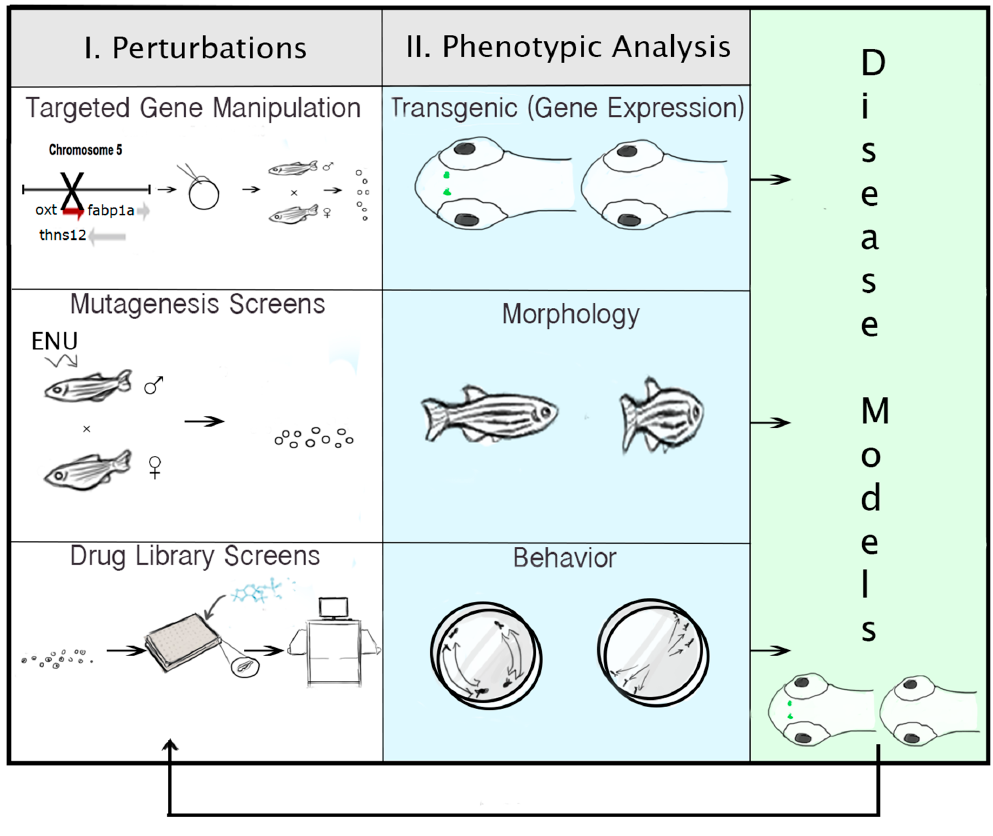
Figure 1. Overview of approaches for investigating PWS using zebrafish. ( I ) Genes and molecular pathways can be genetically or pharmacologically perturbed. ( II ) The effect of perturbations can be evaluated using a variety of phenotypic analyses. PWS endophenotypes may then be utilized as disease models and subjected to drug screening to identify potential pharmacotherapeutics.